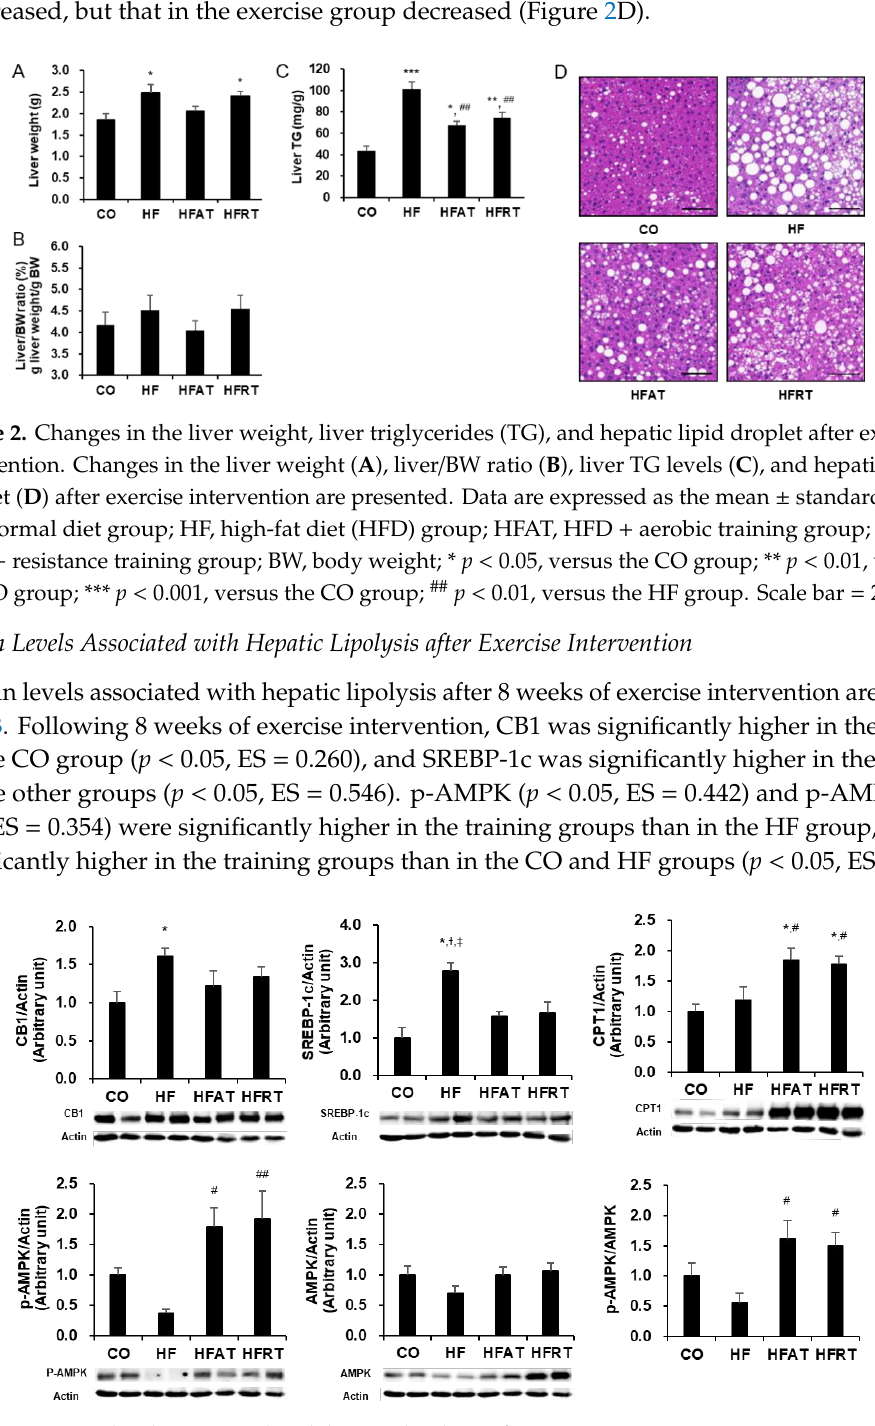
Figure 3. Protein levels associated with hepatic lipolysis after exercise intervention. Data are expressed as the mean ± standard error. CB1, cannabinoid receptor 1; SREBP-1c, sterol-regulatory element binding protein 1; CPT1, carnitine palmitoyltransferase 1; p-AMPK, phosphor-AMP-activated protein